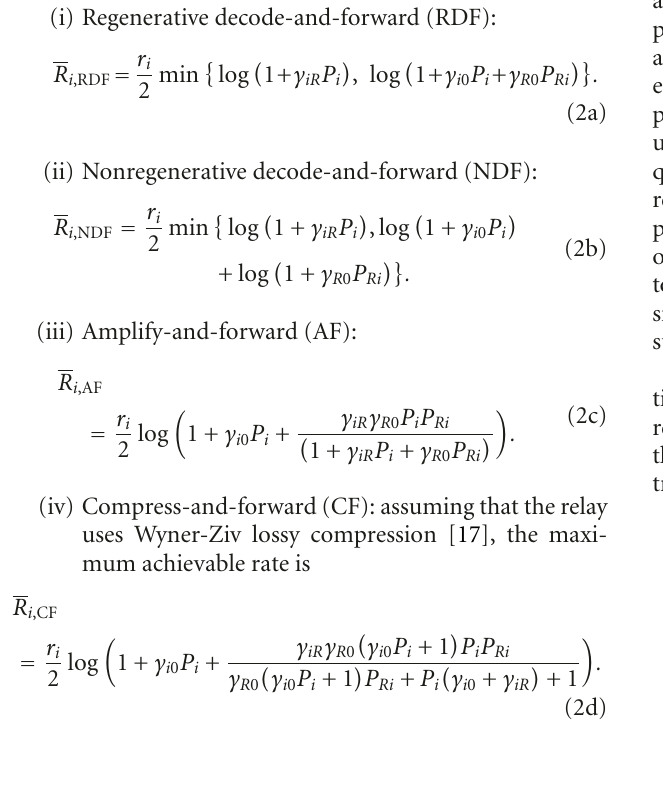
and j ∈ { R ,0 } , represents the channel gain between nodes i and j ; z j represents the additive zero mean white circular at node j ; and 0 is complex Gaussian noise with variance σ 2 j used to represent blocks in which the receiver of the relay node is turned o ff . For simplicity, we define the e ff ective power gain γ ij = | K ij | 2 /σ 2 j